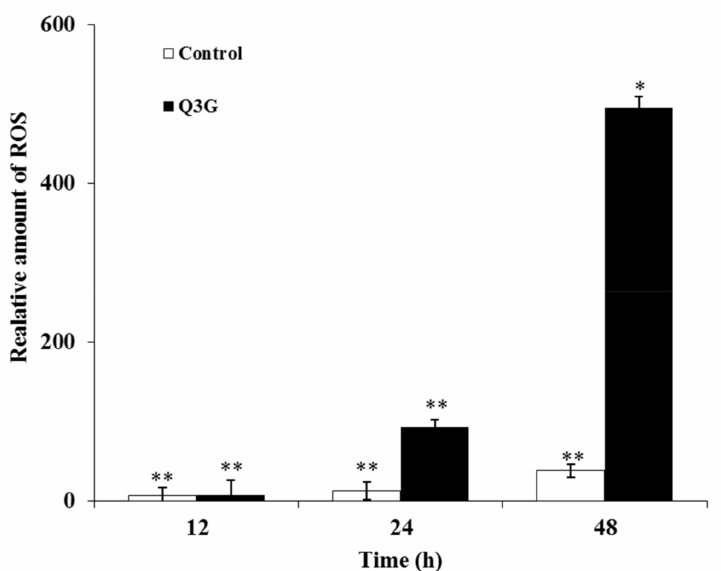
Figure 6. Time-dependent effects of Q3G on the production of intracellular reactive oxygen species (ROS). Hela cells were exposed to 30 µ g of Q3G for 12, 24, and 48 h. Amounts of intracellular ROS in Hela cells were quantified using fluorescence spectrometer. * p < 0.05, ** p < 0.01 indicate the significant differences from the